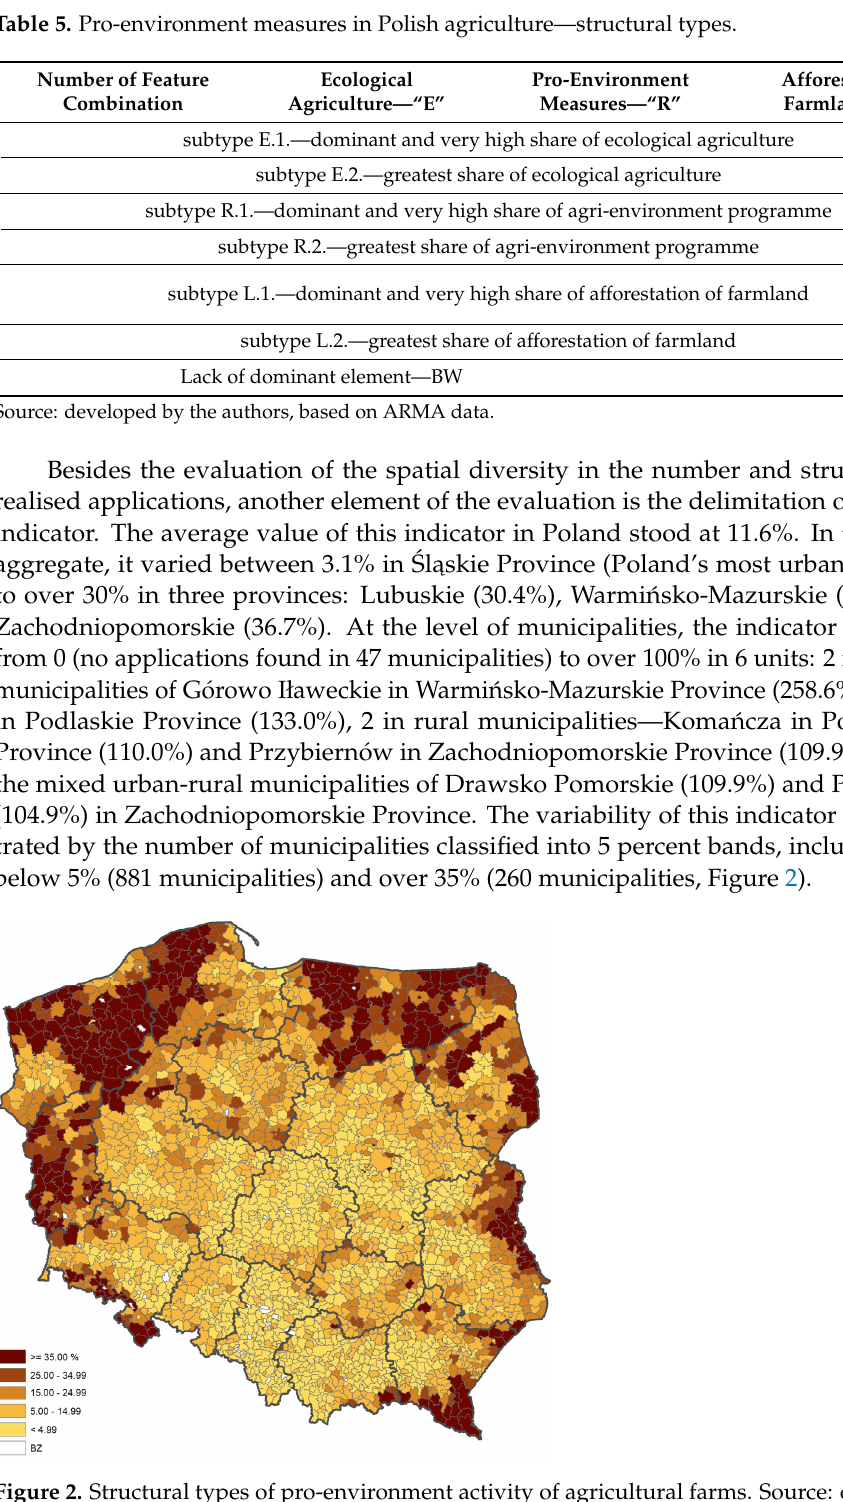
Table 5. Pro-environment measures in Polish agriculture—structural types.